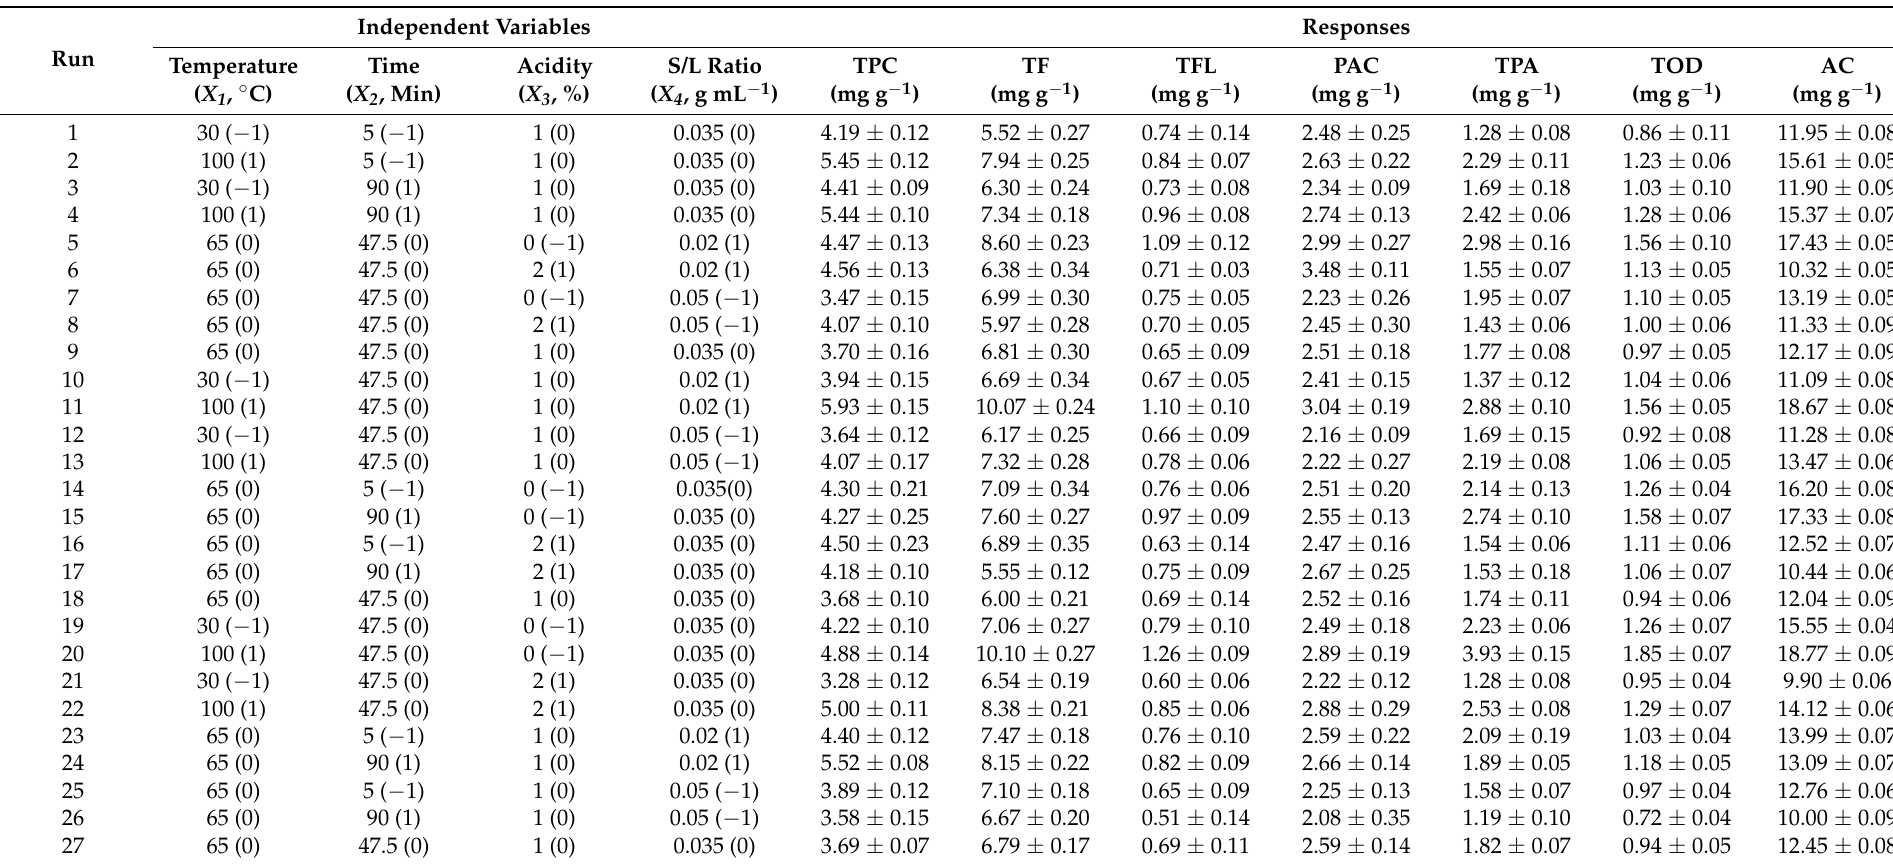
Table 1. Experimental conditions (independent variables) and their corresponding responses values (phenolic compounds content) according to the Box–Behnken design. S/L ratio: solid-to-liquid ratio; TPC: total phenolic compounds; TF: total flavonoids; TFL: total flavanols; PAC: total proanthocyanidin; TPA: total phenolic acid; TOD: total ortho -diphenols; AC: antioxidant